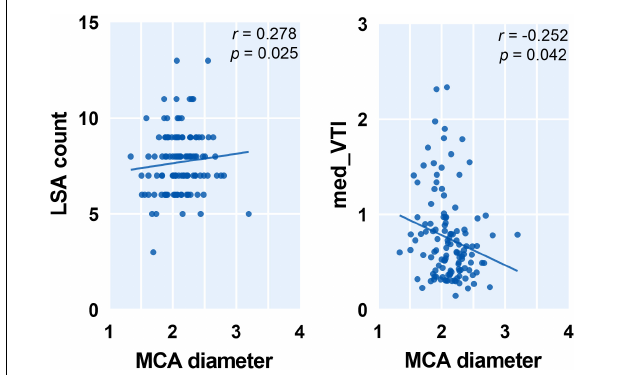
FIGURE 5 | Correlation between middle cerebral artery (MCA) diameter and measurements of lenticulostriate arteries (LSAs). Med, medium; VTI, vessel tortuosity